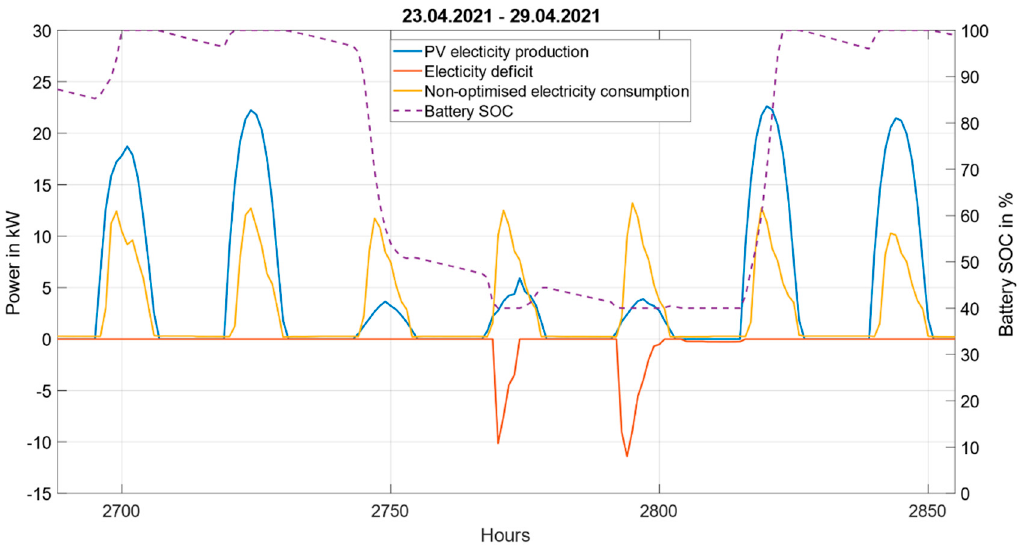
Figure 21. Hourly PV electricity production, demand, and deficit in kW for a week in April (23.04–29.04).